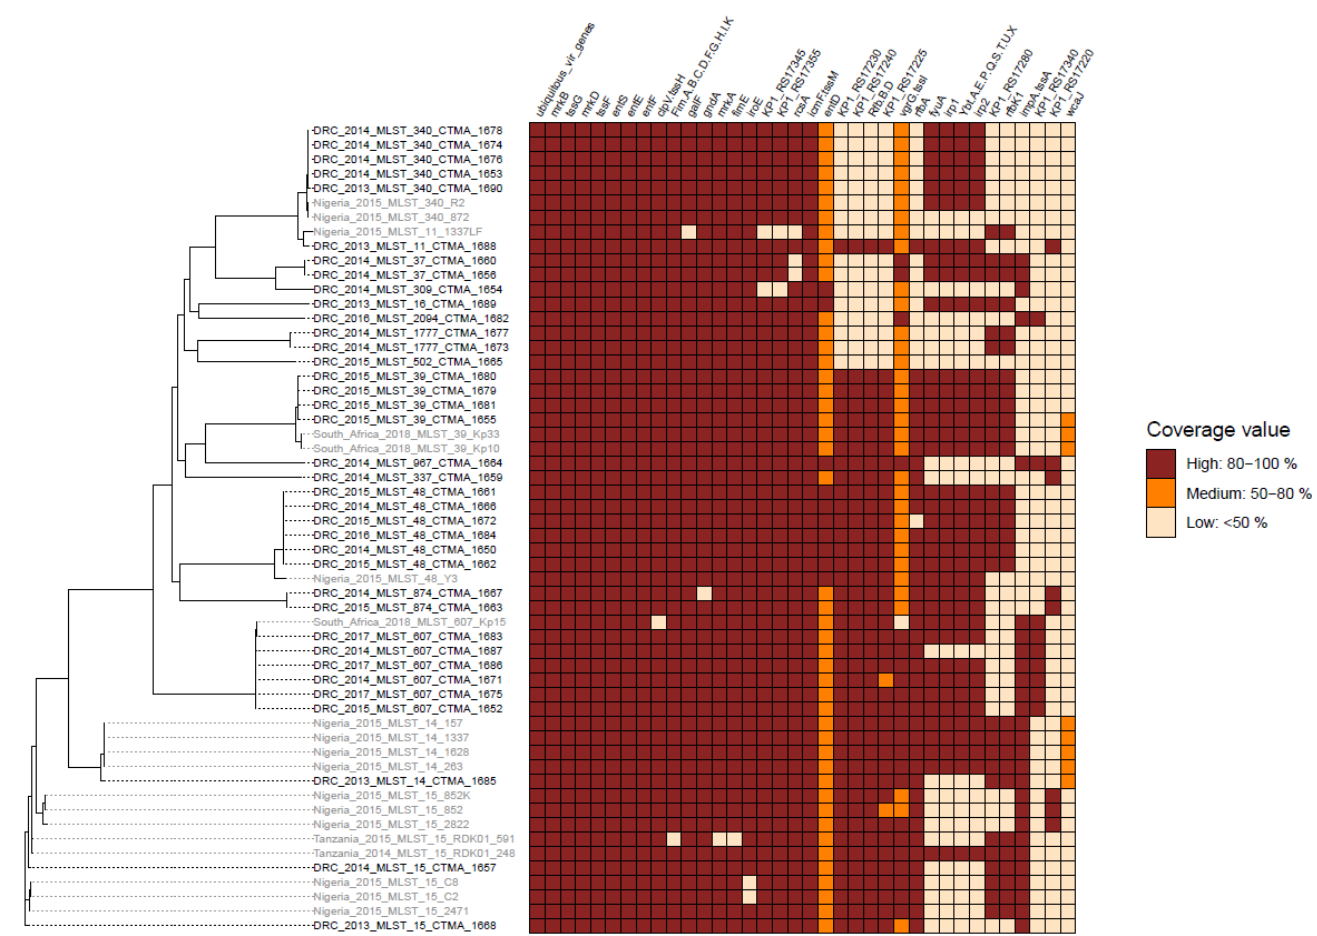
Figure 1. Phylogenetic tree of MDR ESBL-producing K. pneumoniae isolates from the DRC and other countries. The heatmap of K. pneumoniae -related virulence genes from the Virulence Factor Database (VFDB) is shown on the right side of the figure. The kSNP3 parsimony tree is based on single nucleotide polymorphisms (SNPs) within the core genomes of K. pneumoniae isolates from the DRC (in black) as well as isolates from sub-Saharan countries such as Nigeria, Tanzania, and South Africa (in grey). The heatmap’s red cells represent highly (>80%) covered genes, while the orange and yellow cells represent partially (50–80%) covered and uncovered (<50%) genes, respectively. Several genes, including entD and vgrG , have large deletions. acrA , acrB , dotU - tssL , entA , entB , entC , fepA , fepB , fepC , fepD , fepG , fes , hcp - tssD , iutA1 , mrkC are examples of ubiquitous virulence genes.